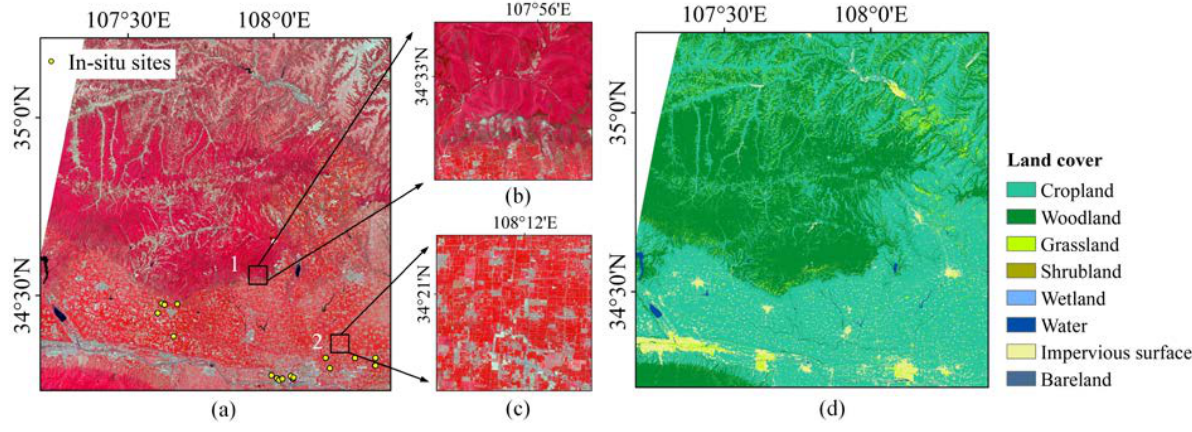
Figure 1. Map of the study area. ( a ) Visible near-infrared composite Sentinel-2 images. ( b , c ) The subarea with high spatial heterogeneity. ( d ) FROM-GLC10 land cover map. subarea with high spatial heterogeneity. ( d ) FROM-GLC10 land cover